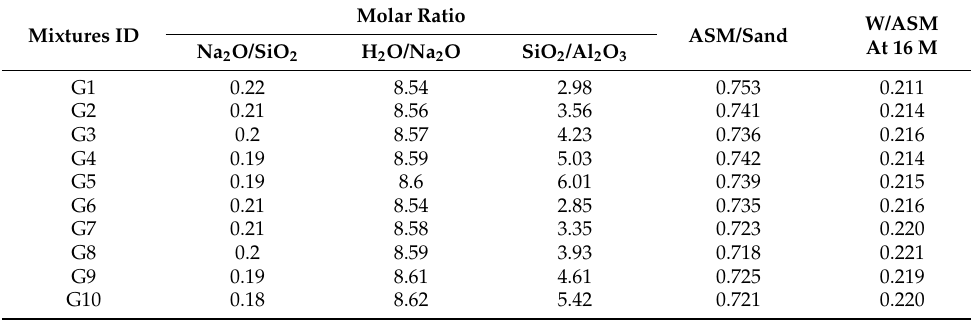
Table 4. Critical molar ratios and W/ASM ratio of the UHPGC